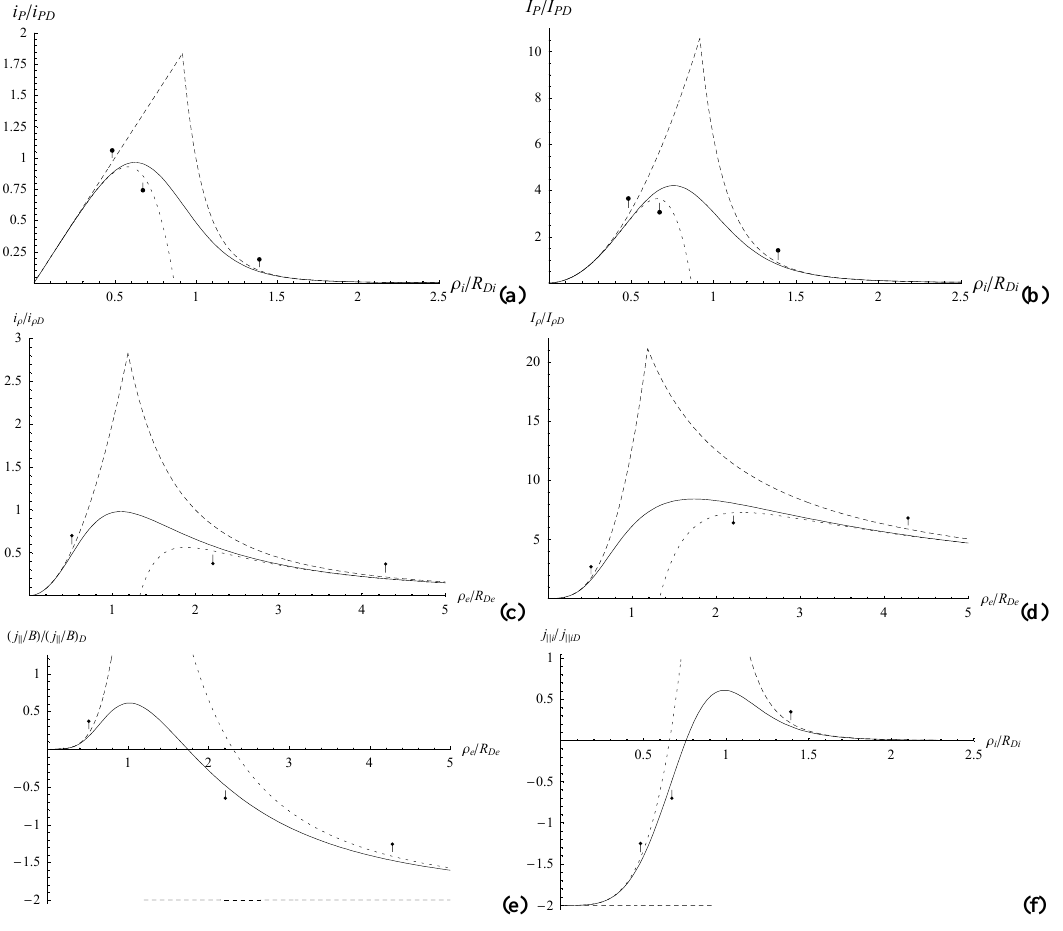
Fig. 3. Plots of normalised steady-state current components for a dipole magnetic field, plotted versus normalised equatorial radial distance (ρ e /R De ) , or normalised distance from the magnetic axis (ρ i /R Di ) in the ionosphere, as appropriate. The plots show (a) the height- integrated ionospheric Pedersen current intensity, (b) the azimuth- and height-integrated total ionospheric Pedersen current, (c) the current sheet-integrated equatorial radial current intensity, (d) the azimuth- and current sheet-integrated total equatorial radial current, ( e ) the equa- torial field-aligned current density per unit magnetic field strength, and (f) the field-aligned current density just above the ionosphere. The corresponding normalization constants are given by Eq. (21). The solid lines show the full solutions given by Eqs. (14) and (21), while the long-dashed lines show the small and large ρ e forms (the ‘ S ’ and ‘ L ’ approximations), shown to their point of intersection at (ρ e /R De ) = 4 √ (or equivalently (ρ i /R Di ) = 1 / 8 2 ) , where (ω/(cid:127) J ) S = (ω/(cid:127) J ) L = 0. The downward-pointing tick marks show the limits of validity of these approximate forms, as shown in Fig. 2. The short-dashed lines show the higher-order large ρ e form (the ‘ L 0 ’ approximation) obtained from Eq. (20), whose limit of validity is indicated by the upward-pointing tick mark, as also shown in Fig. 2.